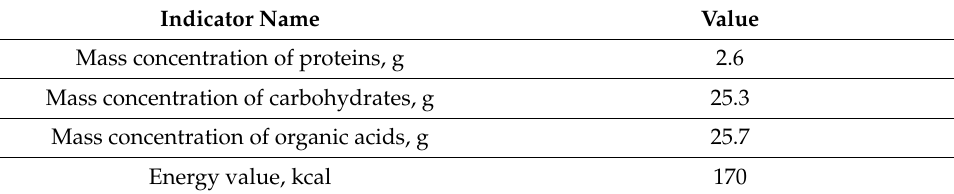
Table 3. Nutritional and energy value of Schisandra Chinensis (Turcz. Baill) (100 g).